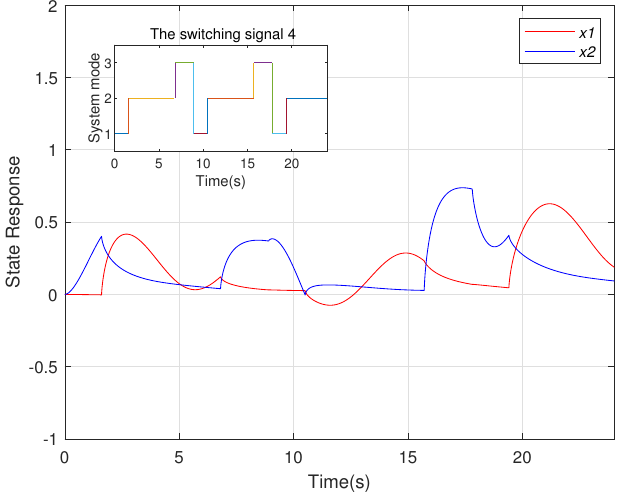
Figure 4. The state response of the system under the signal 4.